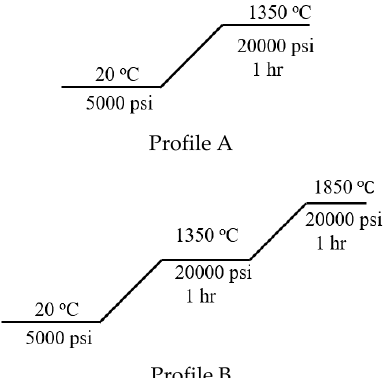
Figure 7. HIP temperature/pressure profiles A and B under argon gas with a ramp rate of 5 °C/min